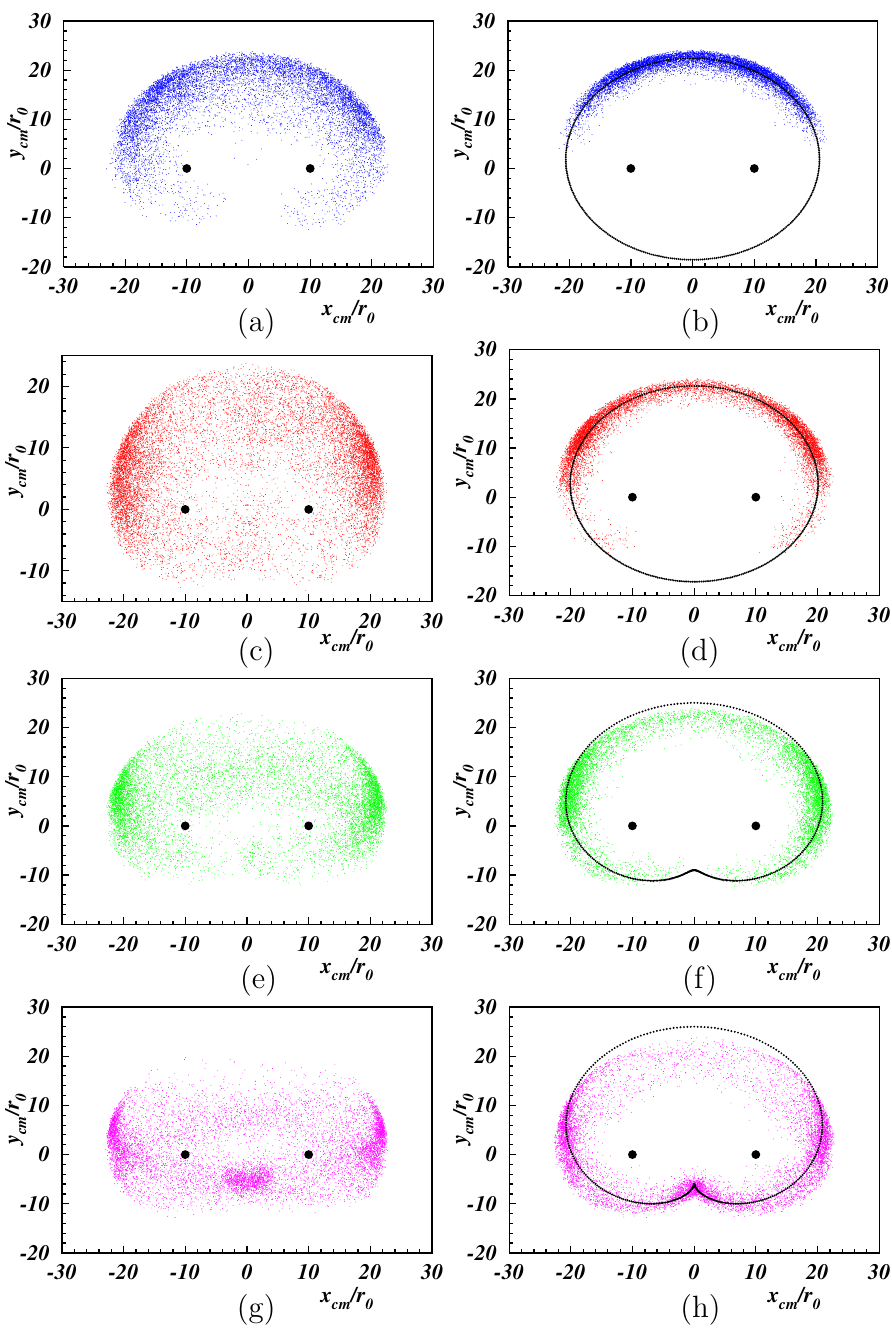
Figure 4. Probability distribution of the center-of-mass position of the tethered polymers for L p / L = 0.5 ( left ) and 2 ( right ), and Wi = 10,25,50,100 ( from top to bottom ). Black dots indicate the position of fixed ends. The lines for L p / L = 2 (right) are lima c ¸ons according to Equations (5) and (6) for the parameters: ( b ) a / r 0 = 20.48, b / r 0 = 1.92, y 0 = 0, ( d ) a / r 0 = 19.91, b / r 0 = 2.72, y 0 = 0, ( f ) a / r 0 =